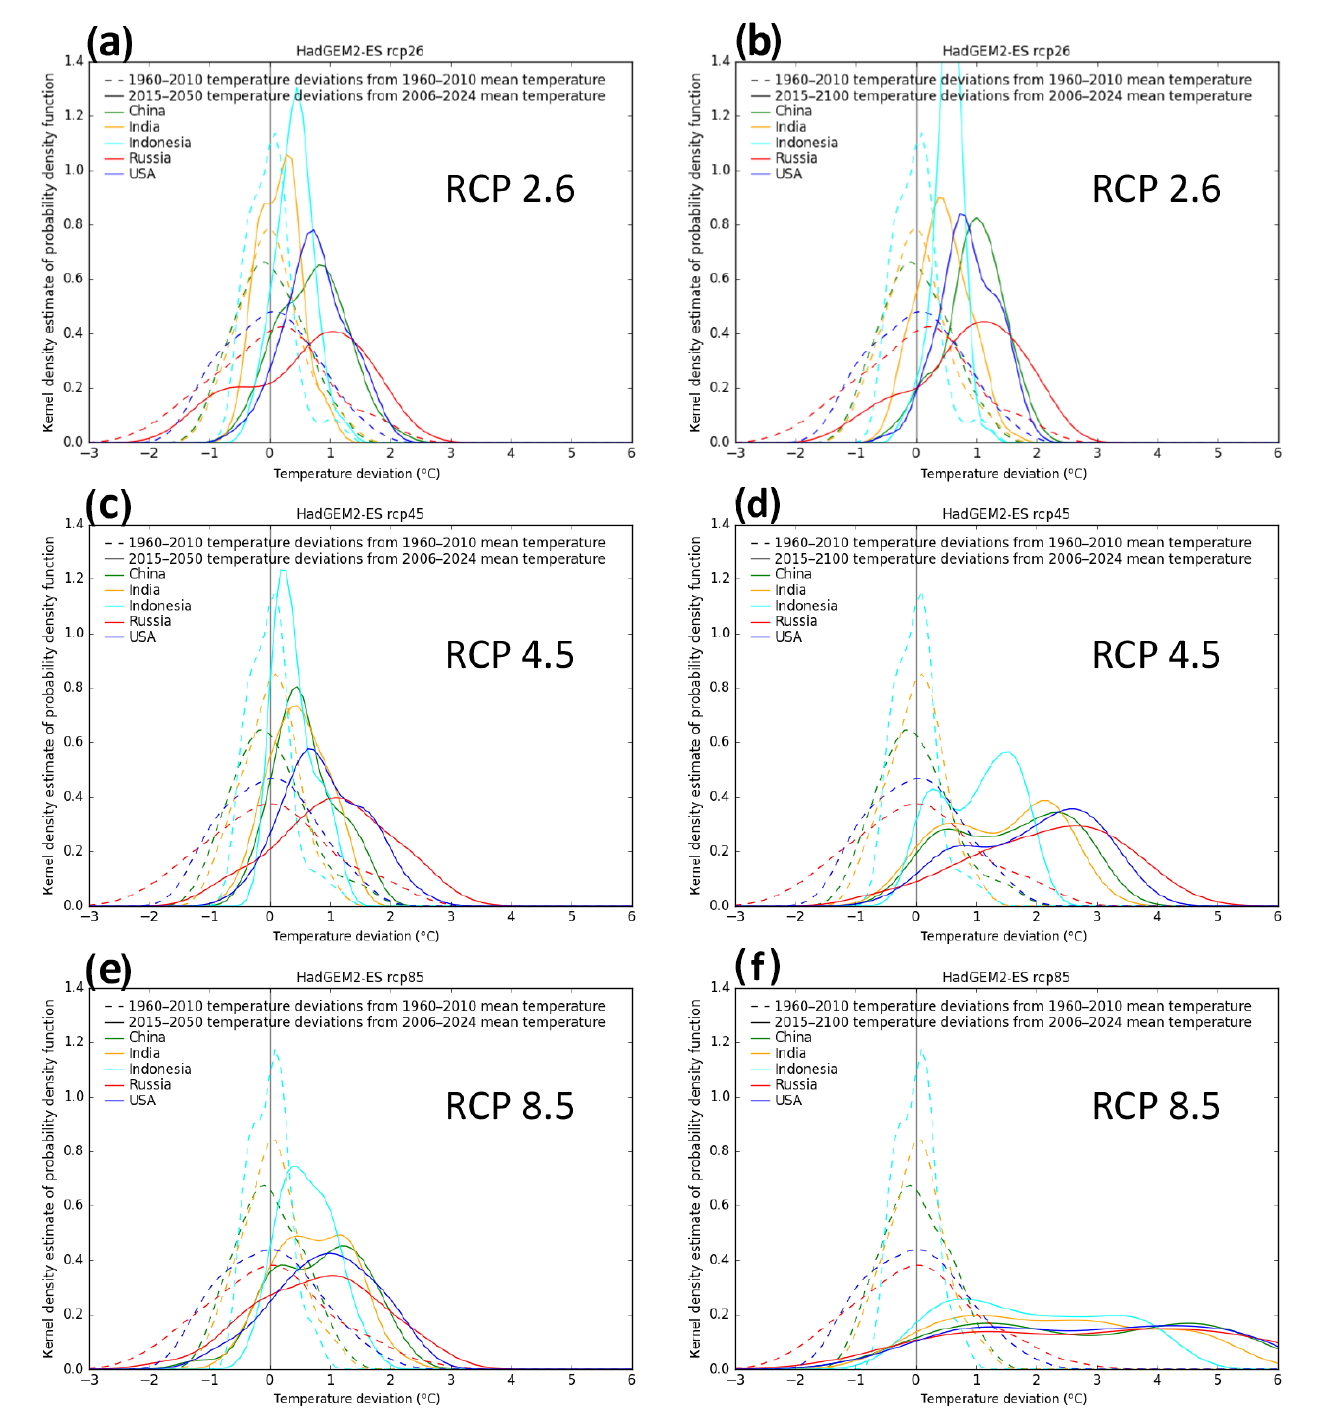
Figure A3. Same as Fig. A2 but from the “warmer” HadGEM2-ES GCM, a comparison of annual temperature deviations for the historical (dashed) and future periods (solid) of 2015–2050 (a, c, e) and 2015–2100 (b, d, f) for China, India, Indonesia, Russia, and the US (colours), and for RCP2.6 (a, b) , RCP4.5 (c, d) , and RCP8.5 (e, f) .